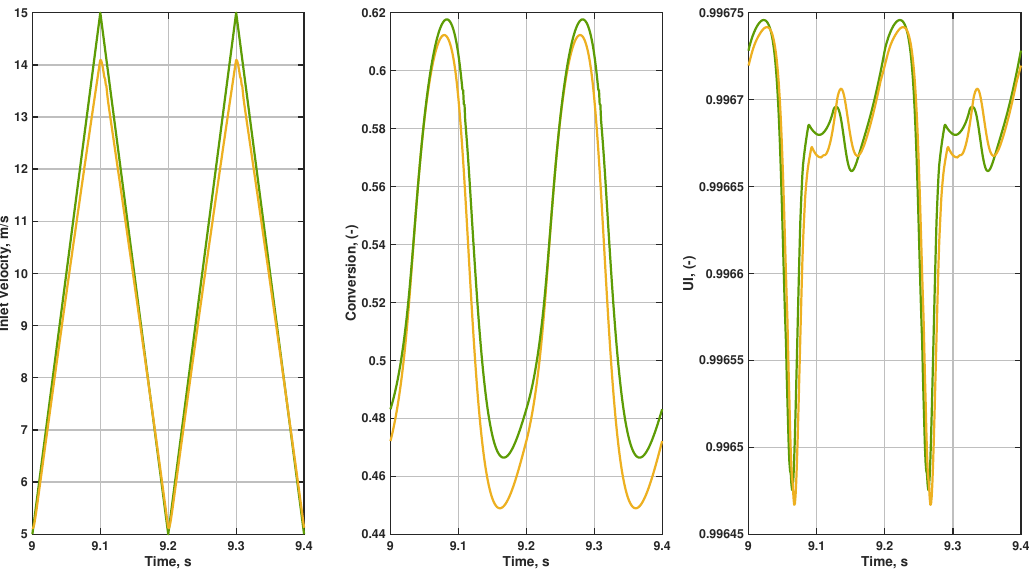
Figure 11. Resulting inlet velocity profiles ( left ), conversion at the system outlet ( middle ) and uniformity index of the reactant field ( right ) over time as obtained in cases 4 (green) and 4B